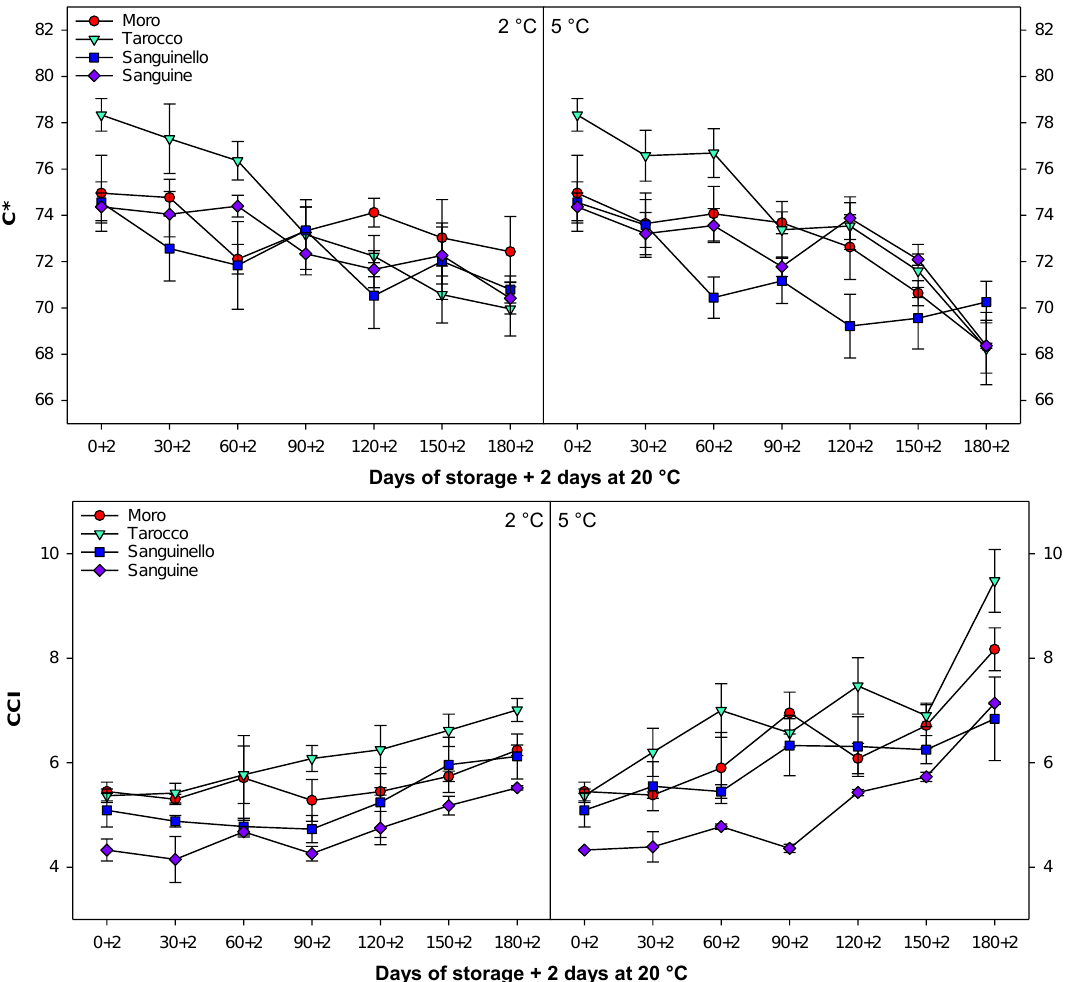
Figure 6. Changes in hue angle (h°), chroma (C * ), and citrus colour index (CCI) of blood orange cultivars ( ‘Moro’ , ‘Tarocco’, ‘Sanguinello’ , and ‘Sanguine’) during cold storage at 2 and 5 °C and 90% relative humidity (RH) plus 2 days at 20 °C. Vertical bars represent ± standard error (SE) of means. LSD ( p < 0.05) values are 1.43, 1.24, and 0.27, respectively.